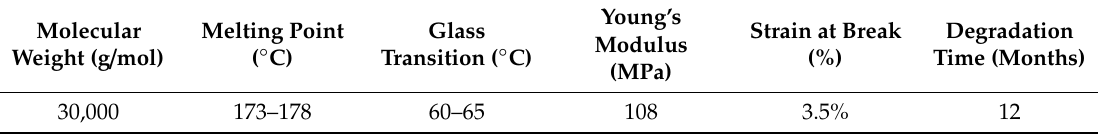
Table 1. Poly(lactic acid)